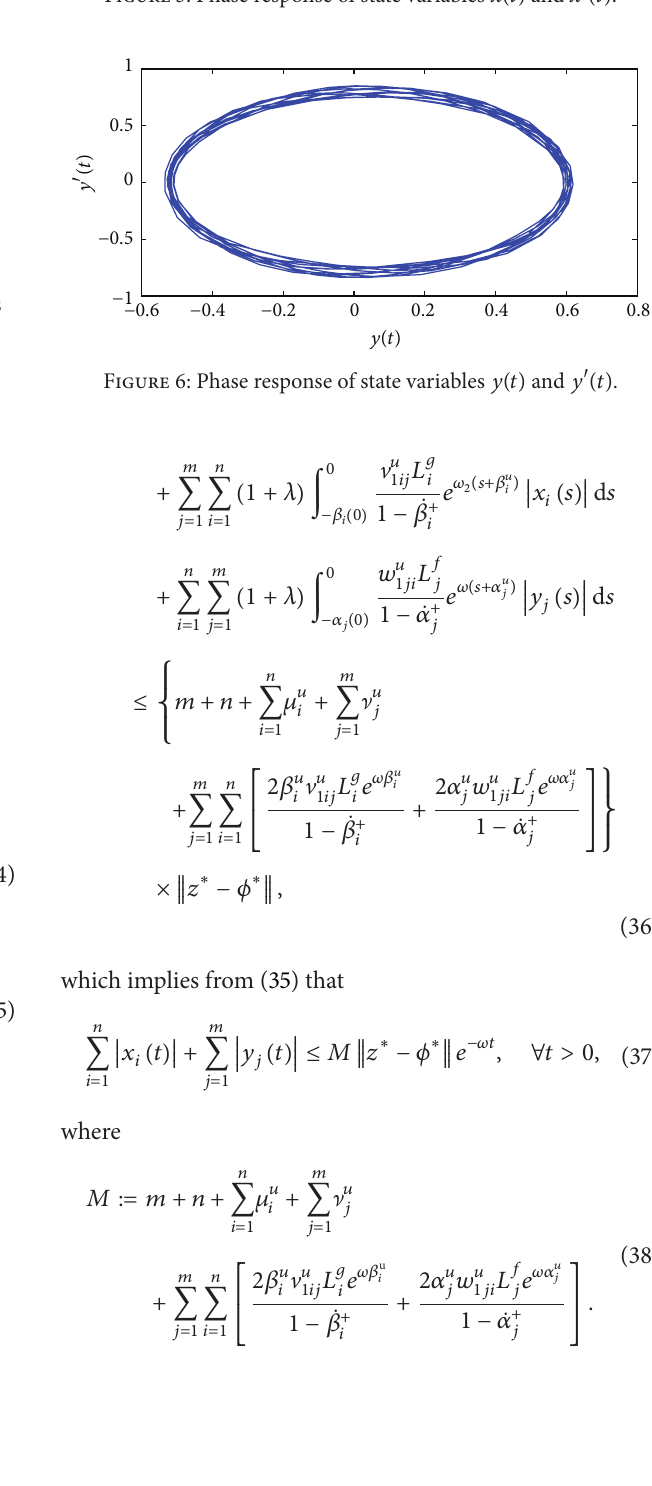
Figure 3: Stability of state variables 𝑦(𝑡) .